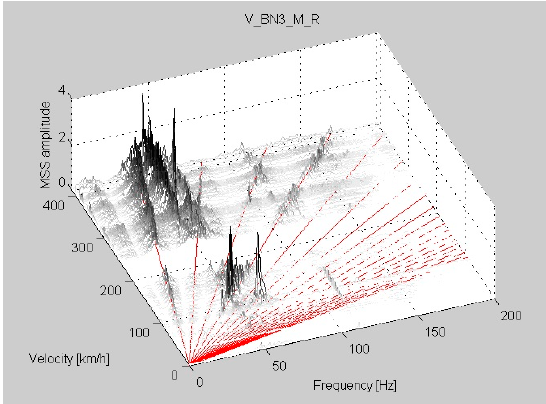
Table 1. Main peak frequencies in the vertical vibration measurements in the axle and bogie. Figure 9. The vibration acceleration spectrogram on the bogie at the vertical direction of the right side of the number 3 bogie, which is in the middle position (center) of each coach car: V_BN3_M_R: Location 3D spectrogram of FFT analysis of vibration acceleration with train speed. The wheel rotation speed (wheel diameter 860 mm) and its integer multiples (harmonic frequencies) are plotted with red lines in the spectrograms.